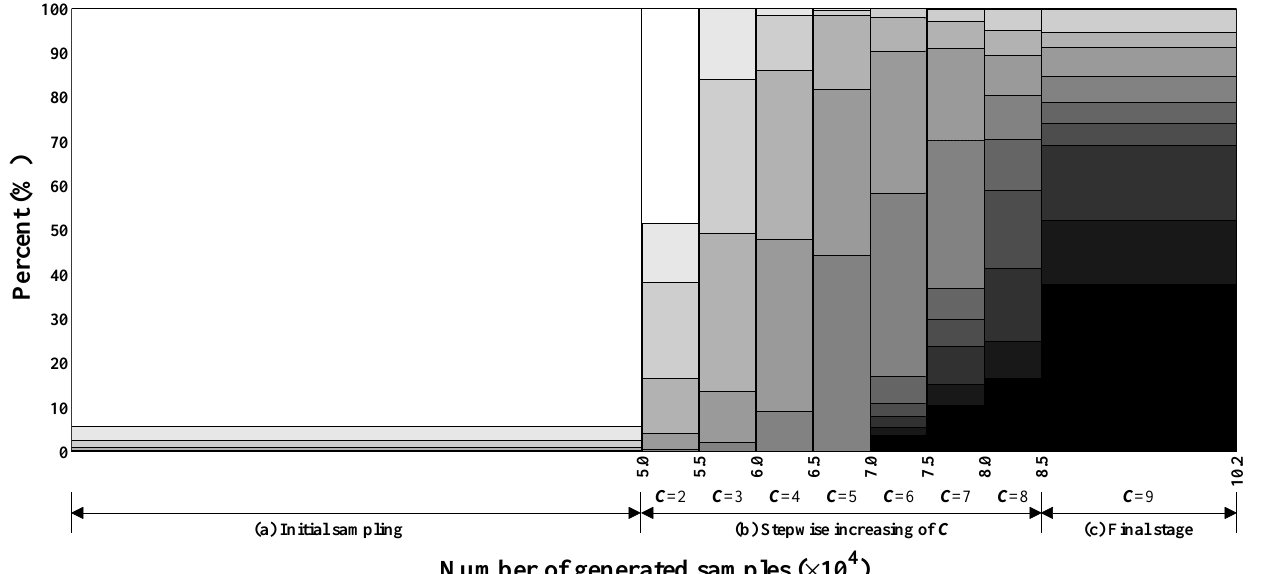
Figure 7. Percentages of samples generated at each stage that satisfy a given number of process constraints. White indicates no satisfied constraints, and progressively darker colors indicate increasing numbers of satisfied constraints. (a) The initial sampling ( N = 50000). (b) Stepwise increase of C , thus requiring an increasing number of process constraints to be satisfied at each stage, and (c) the final stage of the search when C is set to the maximum number of design constraints (here 9), at which point the search continues until 8000 behavioral parameter sets have been